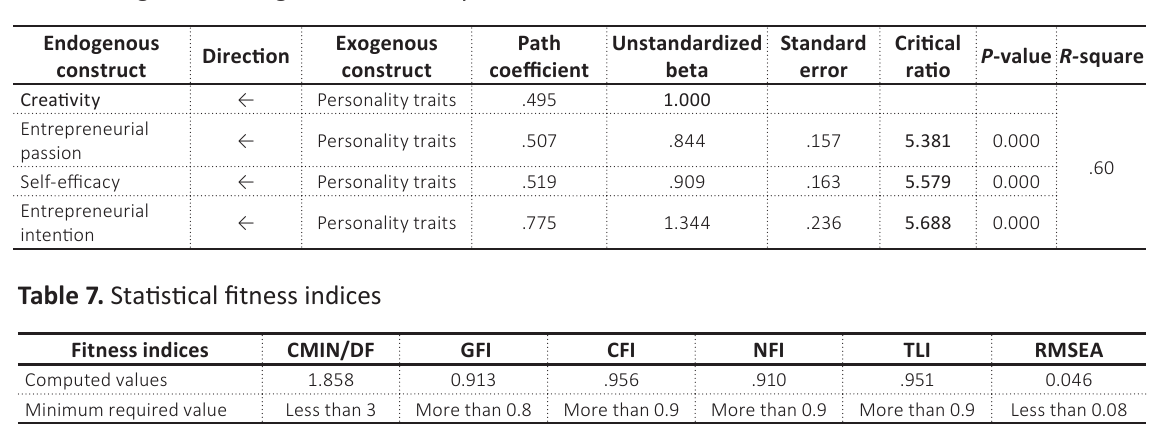
Table 6. Regression weights of SEM analysis